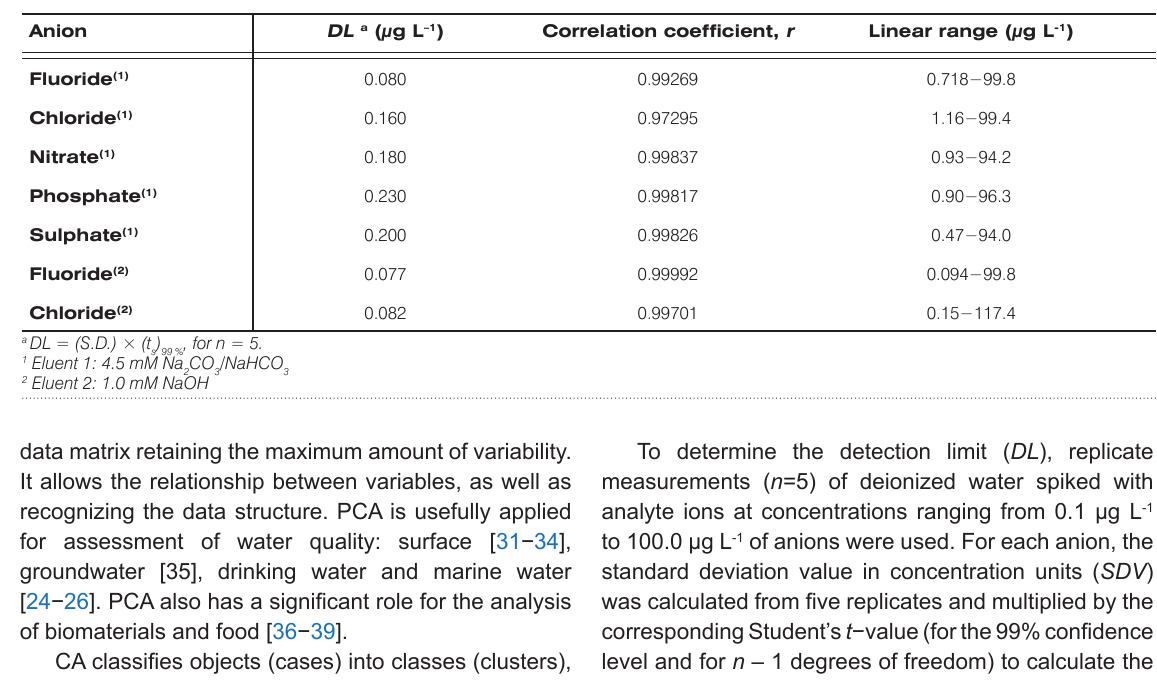
Table 3. Detection limits obtained for the five analyte anions (working range 0.1-100 µg L -1